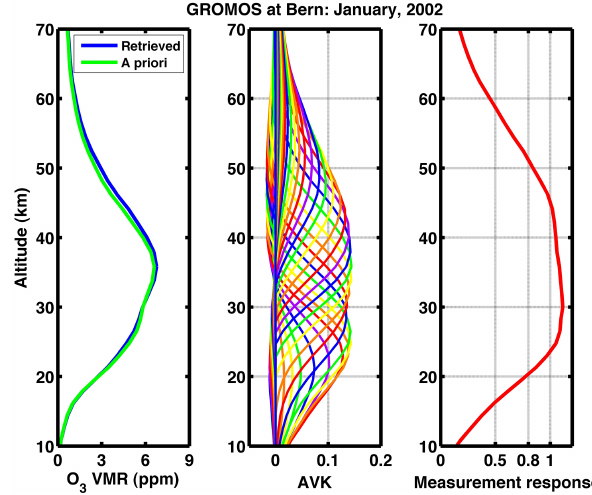
Figure 3. Example of an a priori profile and a retrieved ozone profile (left panel), averaging kernels (middle panel) and the measurement response (area of averaging kernels) (right panel) of the GROMOS retrieval for January,